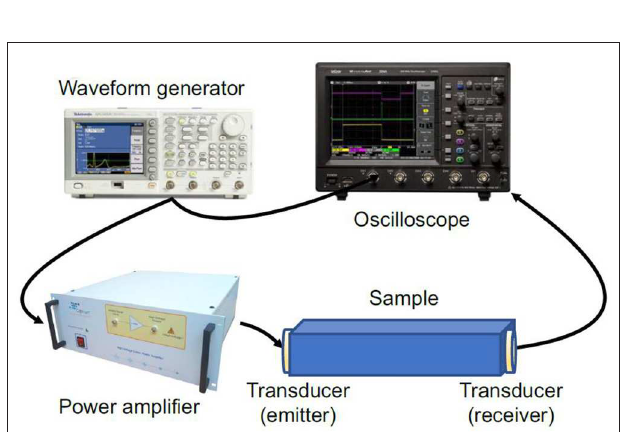
FIGURE 2 | Experimental setup: waveform generator (Tektronix AFG 3022B), amplifier (CIPRIAN US-TXP-3, 200x), two ultrasonic transducers, digital oscilloscope (Lecroy 324A). The generator and oscilloscope were controlled by